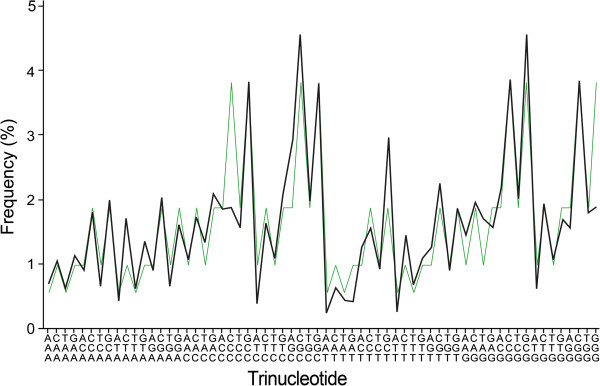
Common profile 2 for genomic trinucleotide frequencies and the average profile of its corresponding random sequences. Common profile 2 was obtained as the average of similar trinucleotide frequency profiles of 160 prokaryotic genomes (chromosomes) with GC content ranging from 58.02% to 74.91%. Alongside common profile 2 is the average trinucleotide frequency profile of 90 random sequences with GC content of 58%–75% and generated according to first-order symmetry. For other explanations see Figure
1.